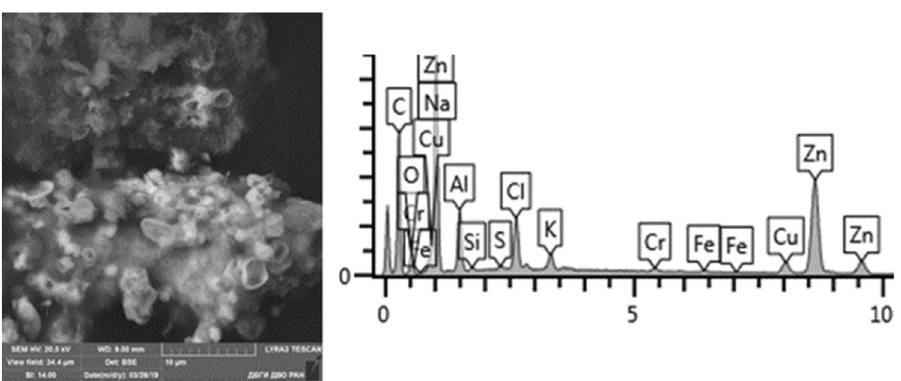
Figure 16. Chemical nickel plating. Particles morphology. Scanning electronic microscopy. Measuring interval 10